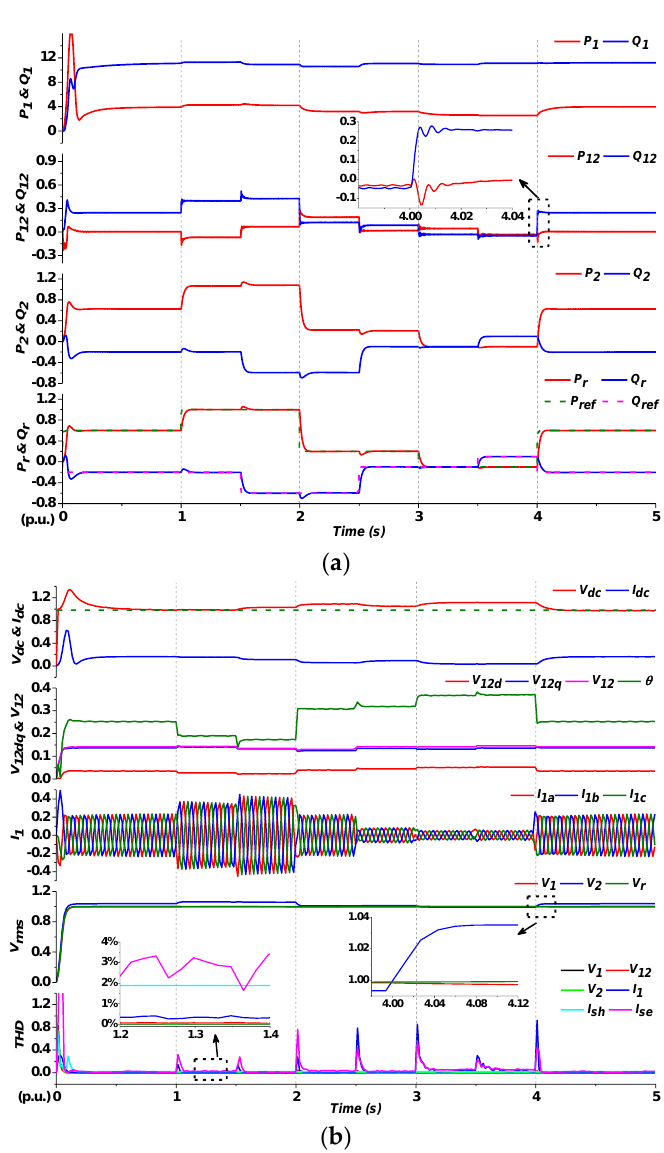
Figure 20. The simulation results of case 1. (a) The results of the power flow of each part; (b) The results of other important parameters.